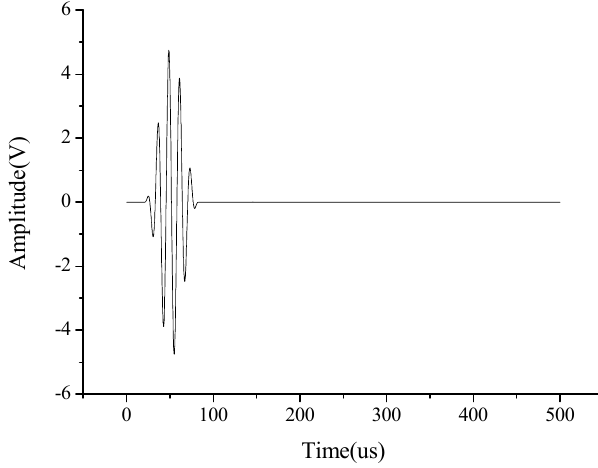
Figure 2. Excitation signal of 5 cycles and 50 kHz actuation frequency.